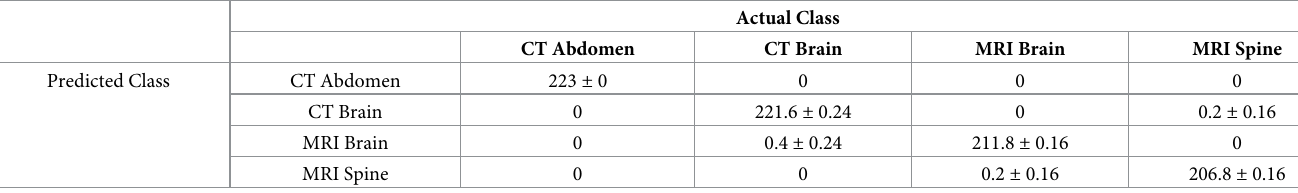
Table 3. Multi-class confusion table for validation set of the five